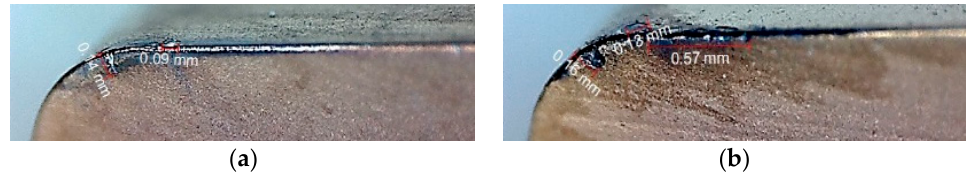
Figure 9. Most worn out cutting edge: ( a ) cutting edge after soft machining tests; ( b ) cutting edge after hard machining.